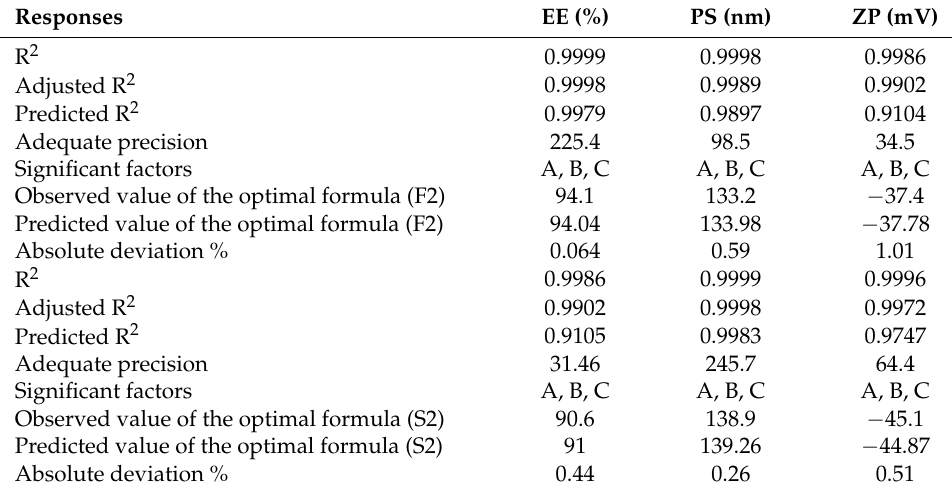
Table 8. The 2 3 factorial analysis outcomes of both 2a and 7 TPGS-modified niosomes and the observed and predicted responses and deviation percent of their optimized formula (S2 and F2),